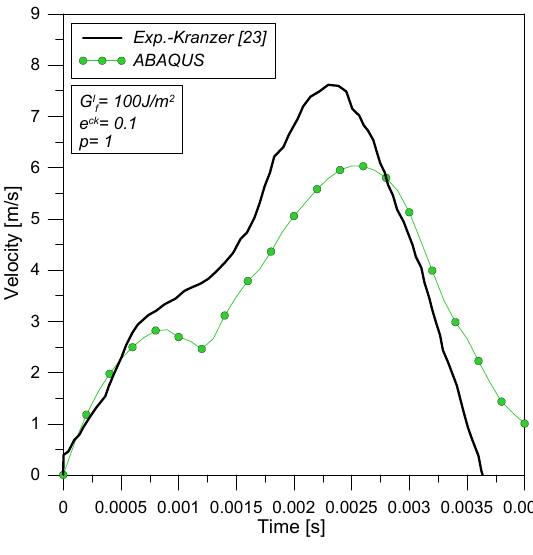
Figure 8. Velocity at the center of panel, as a function of time. Experimental (Kranzer, [23]) and numerical (ABAQUS)